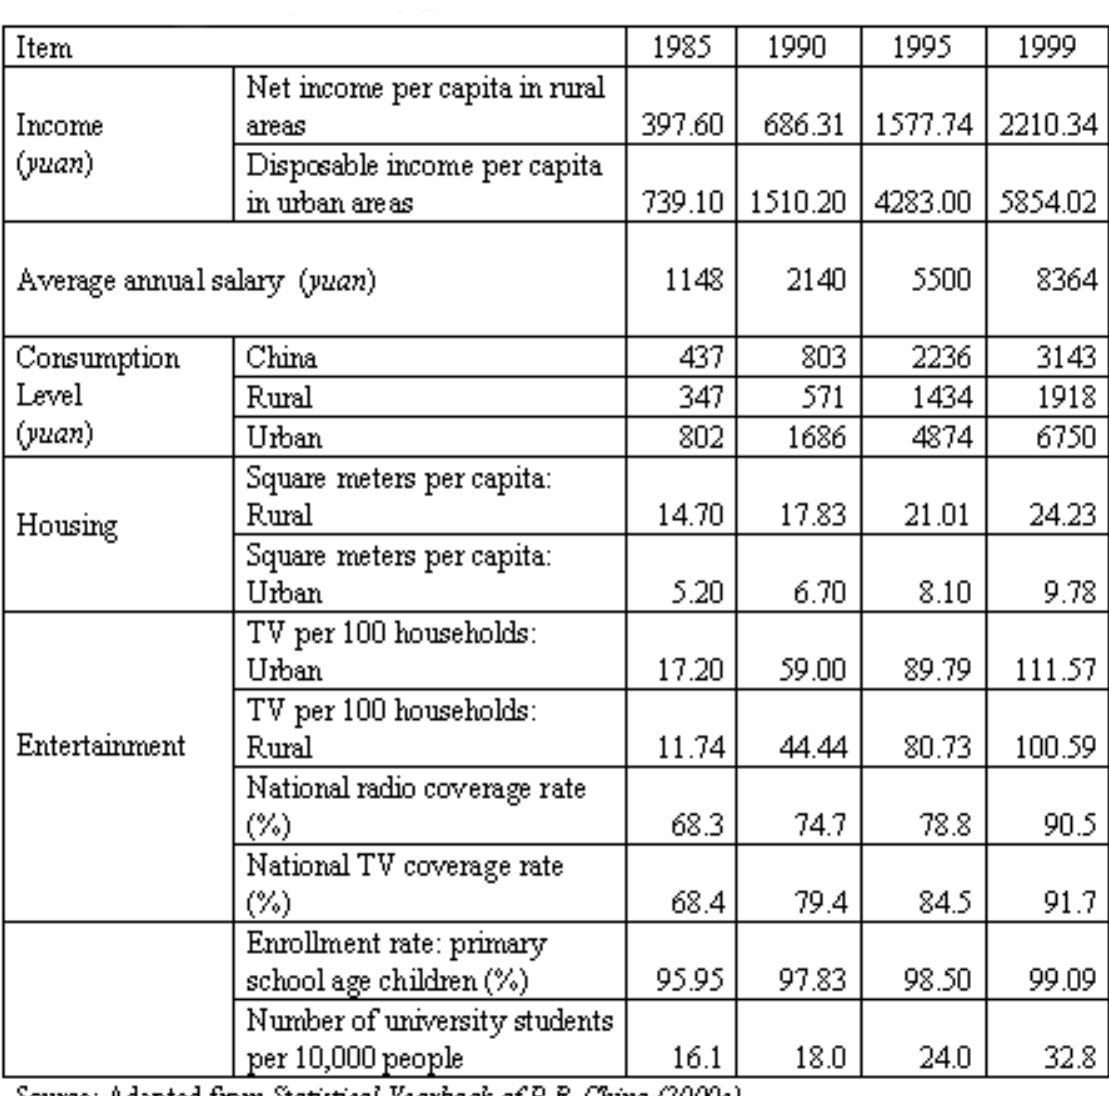
Table 2: Living Standards in China, 1985 -